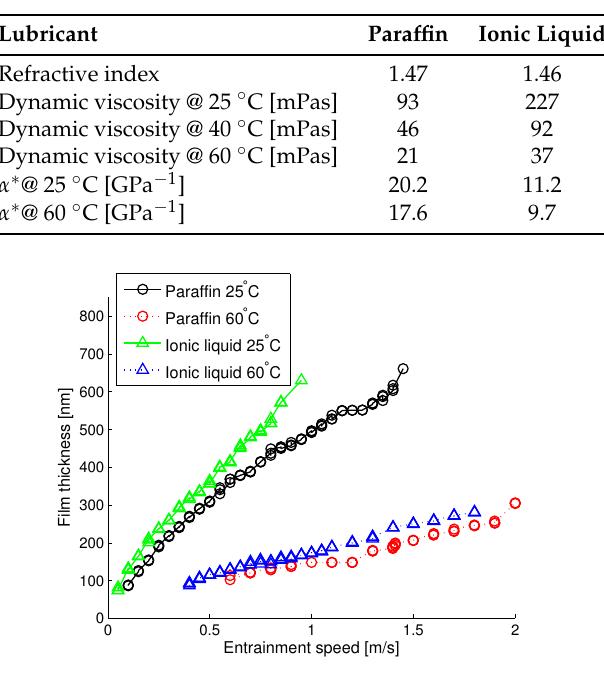
Figure 6. Central film thickness measurements for Paraffin and [Choline] [Proline] at 25 and 60 ◦ C at 0.5 GPa of pressure. [Choline] [Proline] had a water content of slightly below 15 wt %.